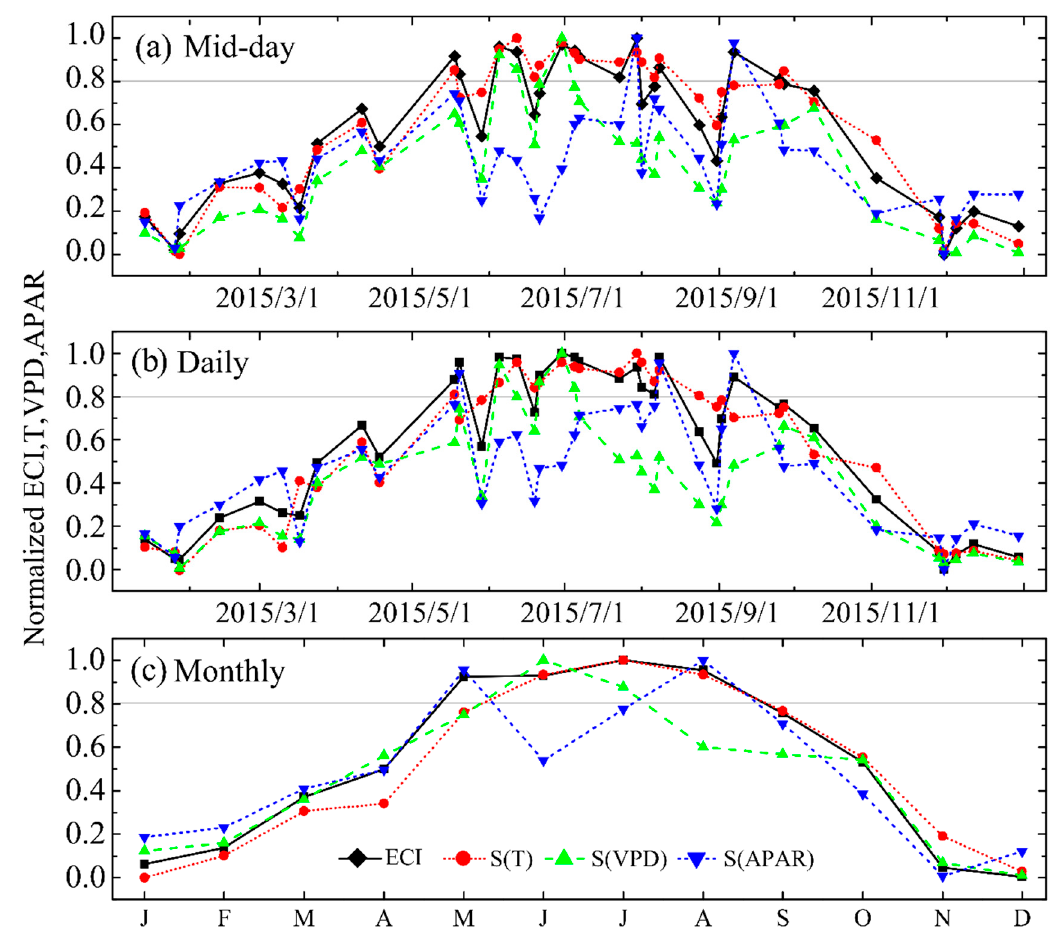
Figure 4. Seasonal dynamics of normalized meteorological conditions (scaled within 0–1), including normalized meteorological condition index (ECI), air temperature, VPD, and APAR at the ( a ) mid-day timescale, ( b ) daily timescale, and ( c ) monthly timescale. The solid grey lines refer to the threshold value of ECI values. The whole canopies are prone to experiencing exposure to excess light when the ECI is greater than 0.8 compared with when the ECI is lower.